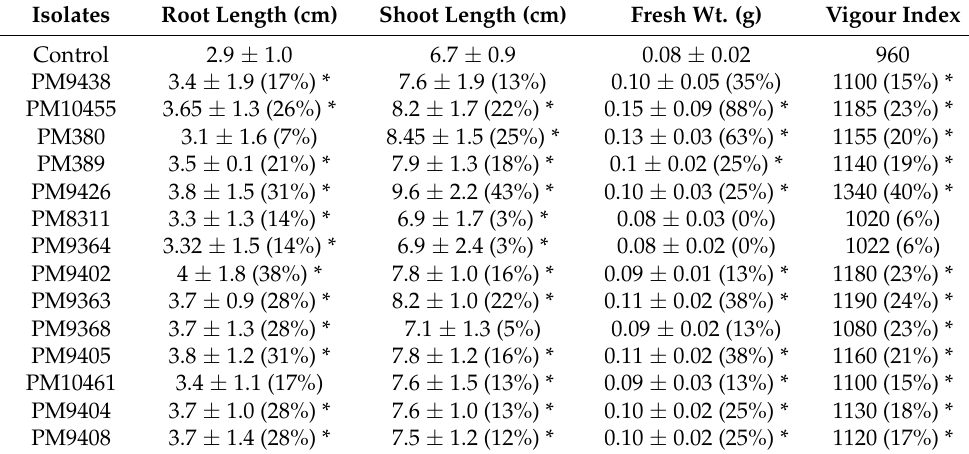
Table 3. Effect of selected bacterial inoculants on growth of wheat